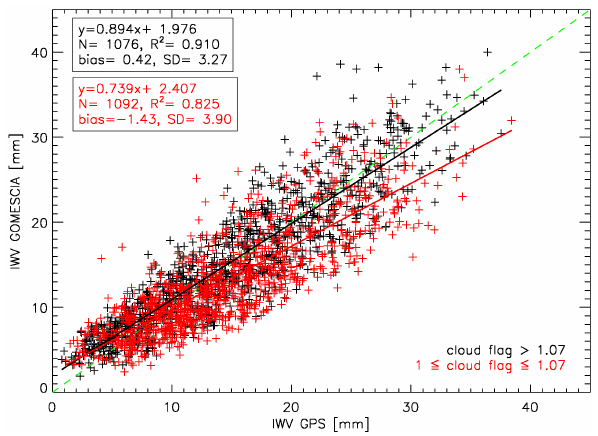
Figure 9. Scatter plot of coincident IWV measurements of GOMESCIA with the GPS device at Uccle, Brussels, Belgium for two different classes of the GOMESCIA cloud flag. Satellite mea- surements with ground pixels including the IGS station are